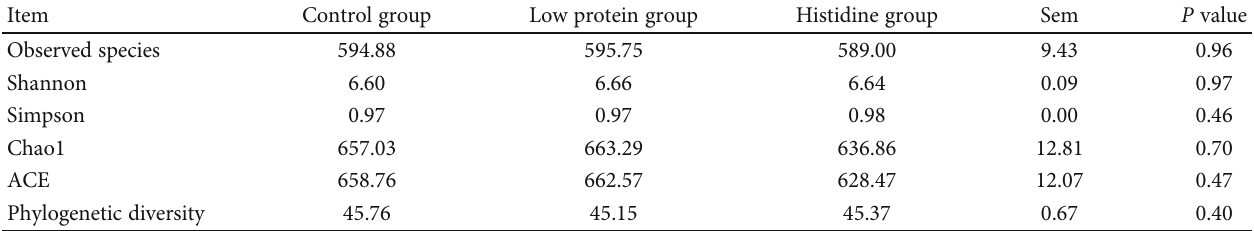
Table 6: E ff ect of dietary histidine on α -diversity of gut microbiota in low protein diet-fed piglets.